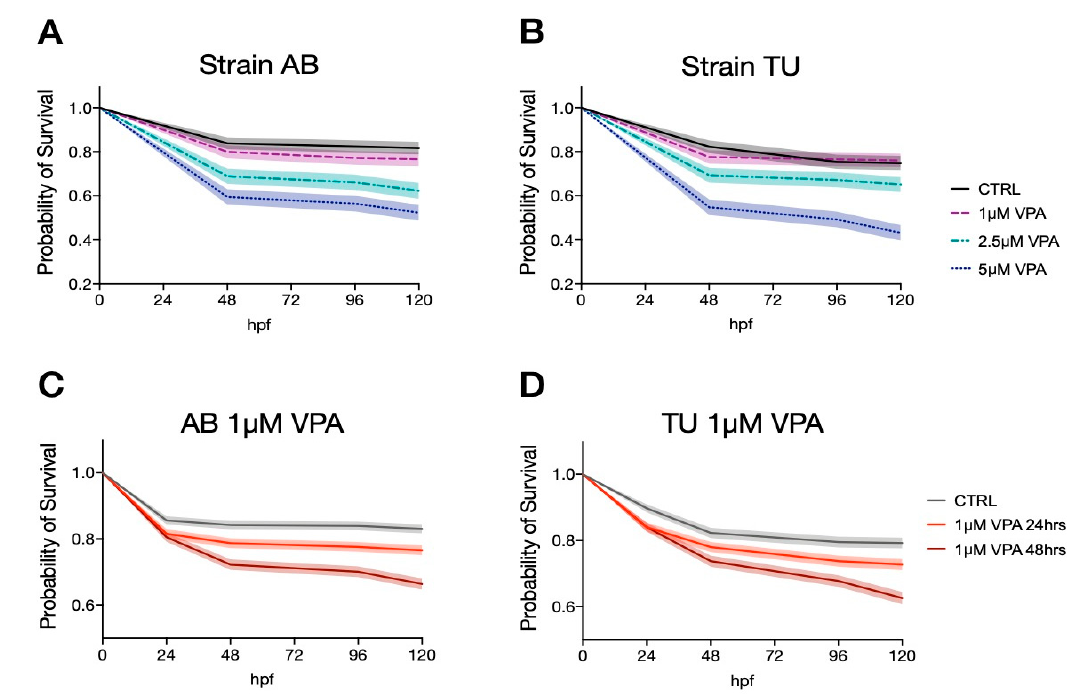
Figure 1. E ff ect of valproic acid (VPA) exposure on zebrafish embryo survival. ( A , B ) Kaplan–Meier survival comparison for groups of treatment showing a significant e ff ect (log-rank (Mantel-Cox) test) of VPA treatment at 1, 2.5 and 5 µ M concentration in AB ( A ) and TU ( B ) strains. ( C , D ) Kaplan-Meier survival comparison showing a significant e ff ect (log-rank (Mantel-Cox) test) of 1 µ M VPA exposure for 24 and 48 h in AB ( C ) and TU ( D ). Probability of survival with shaded color indicating SE.